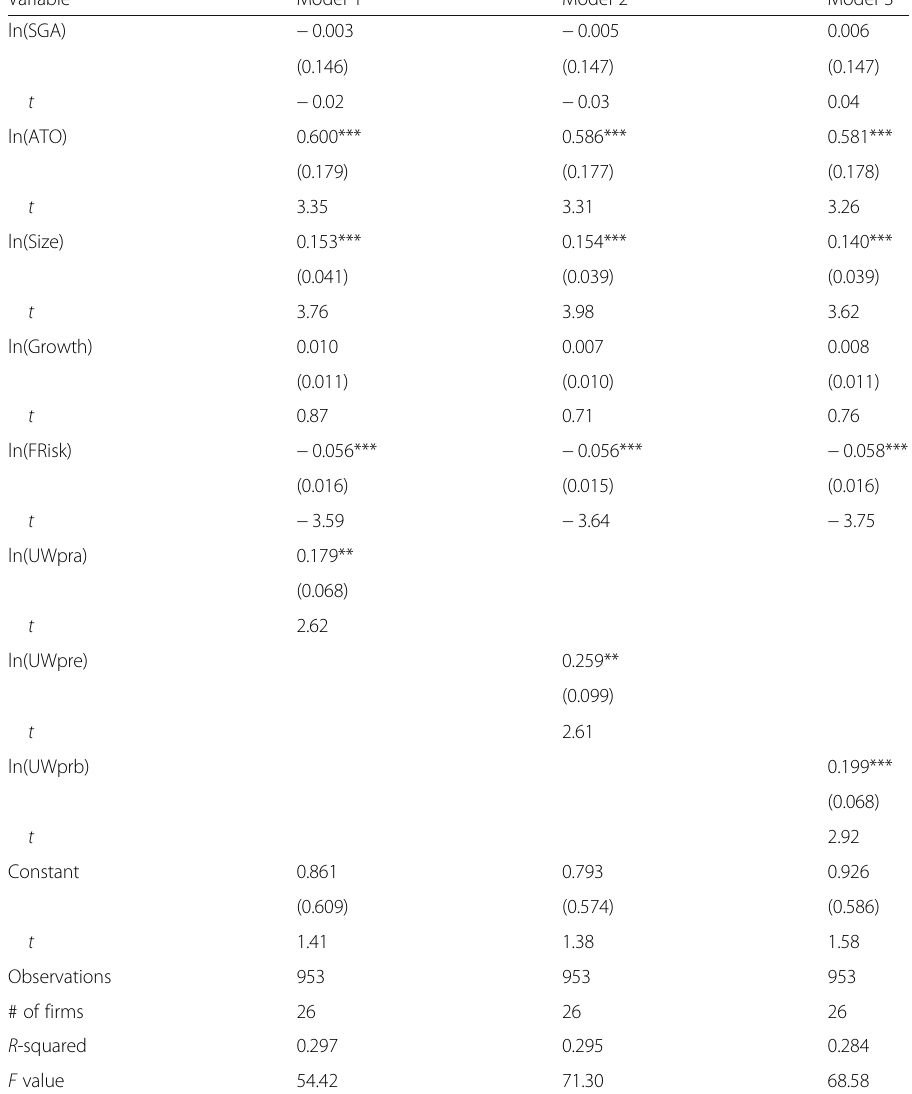
Table 4 Regression with ROA t +1 as the dependent variable Variable Model 1 Model